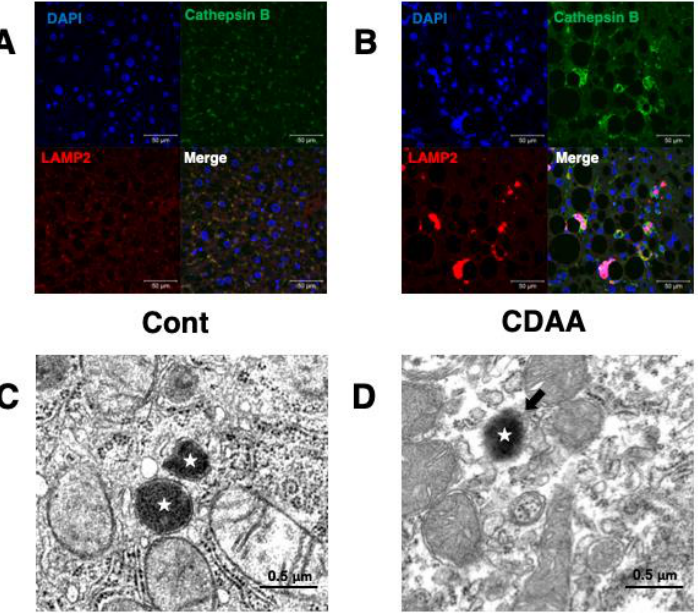
Figure 3. Lysosomal membrane permeabilization (LMP) in the liver tissue of NASH model mice. ( A , B ) Compared to the liver of the control mice being fed by the standard diet (( A ) Cont), the liver of the NASH model mice being fed by the CDAA-diet (( B ) CDAA), shows an enlarged area with the merged color of cathepsin B, LAMP2 and DAPI by immunofluorescence staining. Blue: DAPI, green; Cathepsin B, red: LAMP2. ( C , D ) Electron microscopic photographs of the liver tissue of the control mice (Cont) and CDAA mice (CDAA). The control mouse shows a distinct lysosomal membrane (( C ) stars), whereas the CDAA mouse shows LMP (( D ) arrow). Stars: lysosome. (Cited from Seike et al., Cell Mol Gastroenterol Hepatol. 14:925–944, 2022. https://doi.org/10.1016/j.jcmgh.2022.06.008). 5. Monkey Organ Damage after Hydroxynonenal Injections 5.1. Liver The serum concentration of hydoxynonenal in patients with Alzheimer’s disease is 20.65 μM/l at the median level (range: 6.02–25.20)[40]. The consecutive (5 mg/week × 12 weeks) injections of synthetic hydroxynonenal was carried out in Japanese macaque mon- keys for reproducing this concentration. At autopsy 6 months after hydroxynonenal injec- tions, the gross inspection of the liver showed a mosaic pattern of discoloring at the sur- face. The monkey liver was histologically characterized by widespread hepatocyte necro- sis and lipid depositions [18,23,31]. The necrotic hepatocytes were microscopically char- acterized by an almost complete loss or marked disruption of organelles and nuclear chro- matin. These histological changes were consistent with the characteristics of coagulation necrosis. Through electron microscopic observations, rough ER membranes were severely dis- rupted in the degenerating hepatocytes, and the mitochondria showed a marked dissolu- tion of crista and double membrane (Figure 4A,B, m). Autophagosomes containing cell